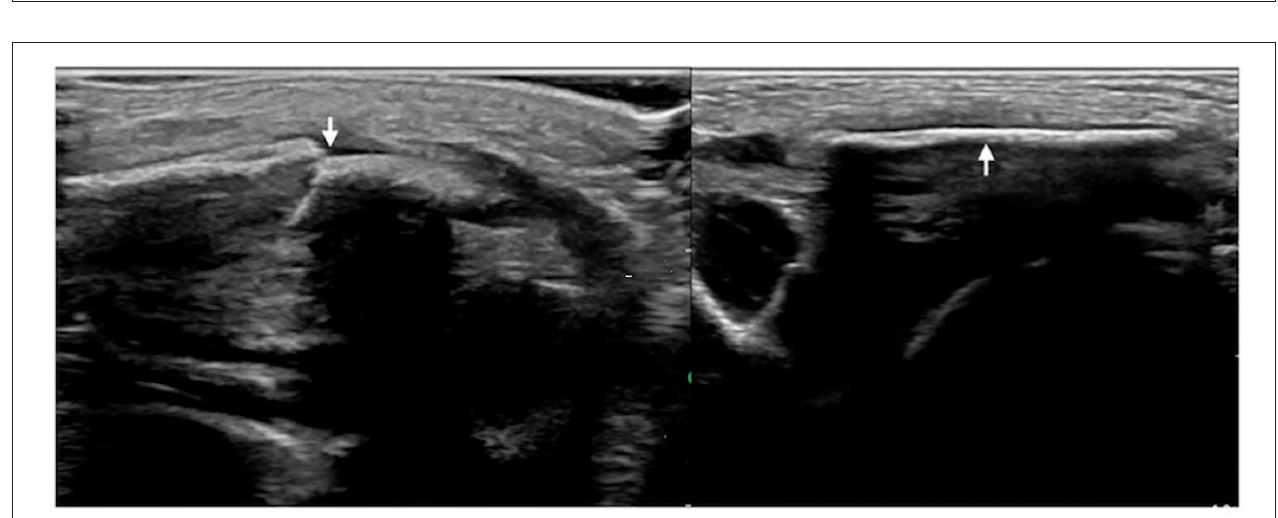
FIGURE 2 | Right clavicle fracture. The infant was G 2 P 1 with a gestational age of 39 + 1 weeks, vaginal delivery, and birth weight of 4,140g. The patient was admitted to the hospital 3h after birth due to intrauterine pneumonia. Physical examination showed that the bilateral clavicles were asymmetrical and that the left side was smooth, while the right side had obvious bone rubbing. Ultrasound revealed interrupted continuity of the cortical bone of the right clavicle and broken end formation and dislocation. The fracture of the clavicle was confirmed by chest X-ray examination.